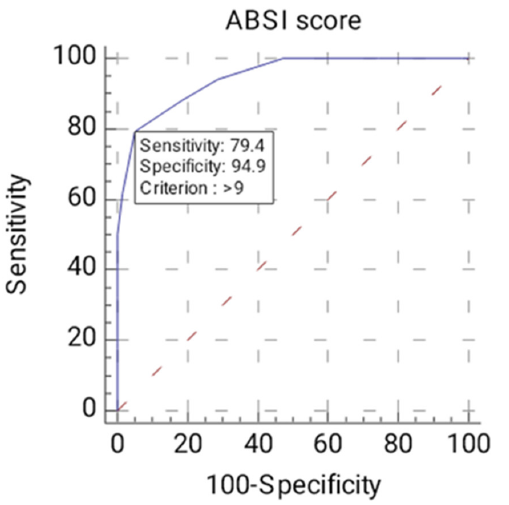
Figure 5. ROC curve for the ABSI variable (ABSI—the Abbreviated Burn Severity Index). In Table 2, we presented the comorbidities encountered among the studied groups. Table 2. Patients’ distribution according to present comorbidities.